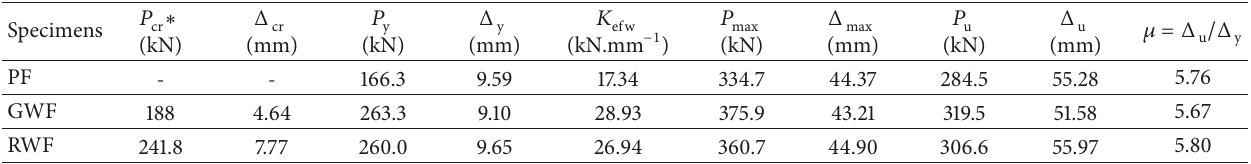
Table 2: Experimental results.